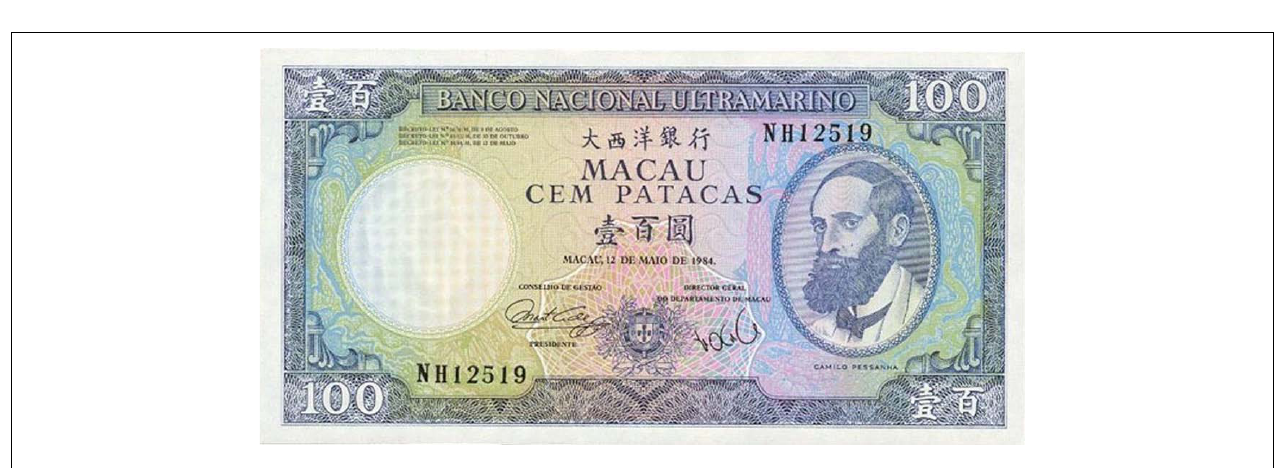
FIGURE 5 |The 1981 version of the 100 Macanese pataca banknote. Both the Chinese name of the issuing bank and the denomination “100 patacas” were in the newer LR direction. (Source: www.vincenzo.altervista.org/catalog/macao/mao061_f.jpg; accessed 6th July